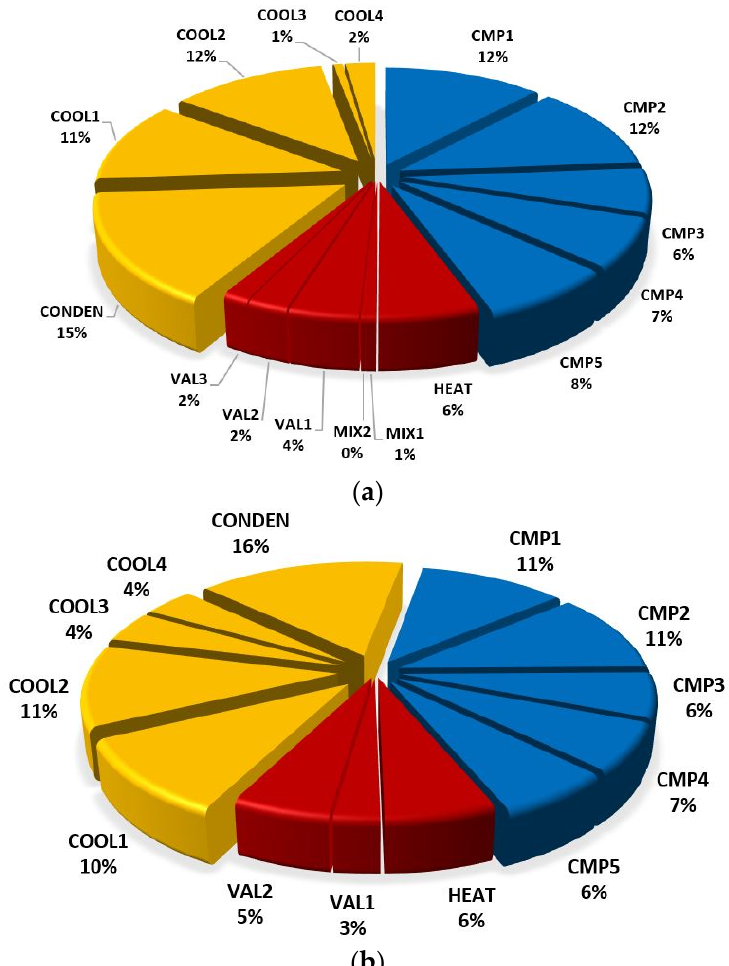
Figure 7. Exergy destruction of components: ( a ) vapor-compression process with R 290; ( b ) precooled Linde–Hampson process with R717.